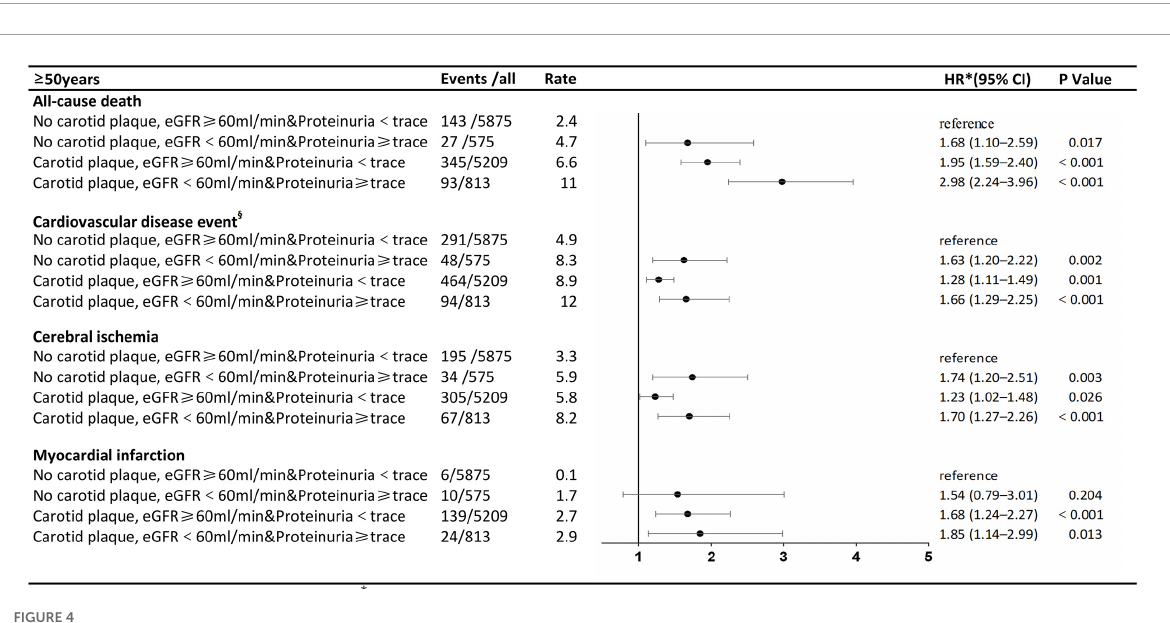
their LDL cholesterol level (40, 41), and that their systolic and diastolic blood pressures be kept at an ideal level